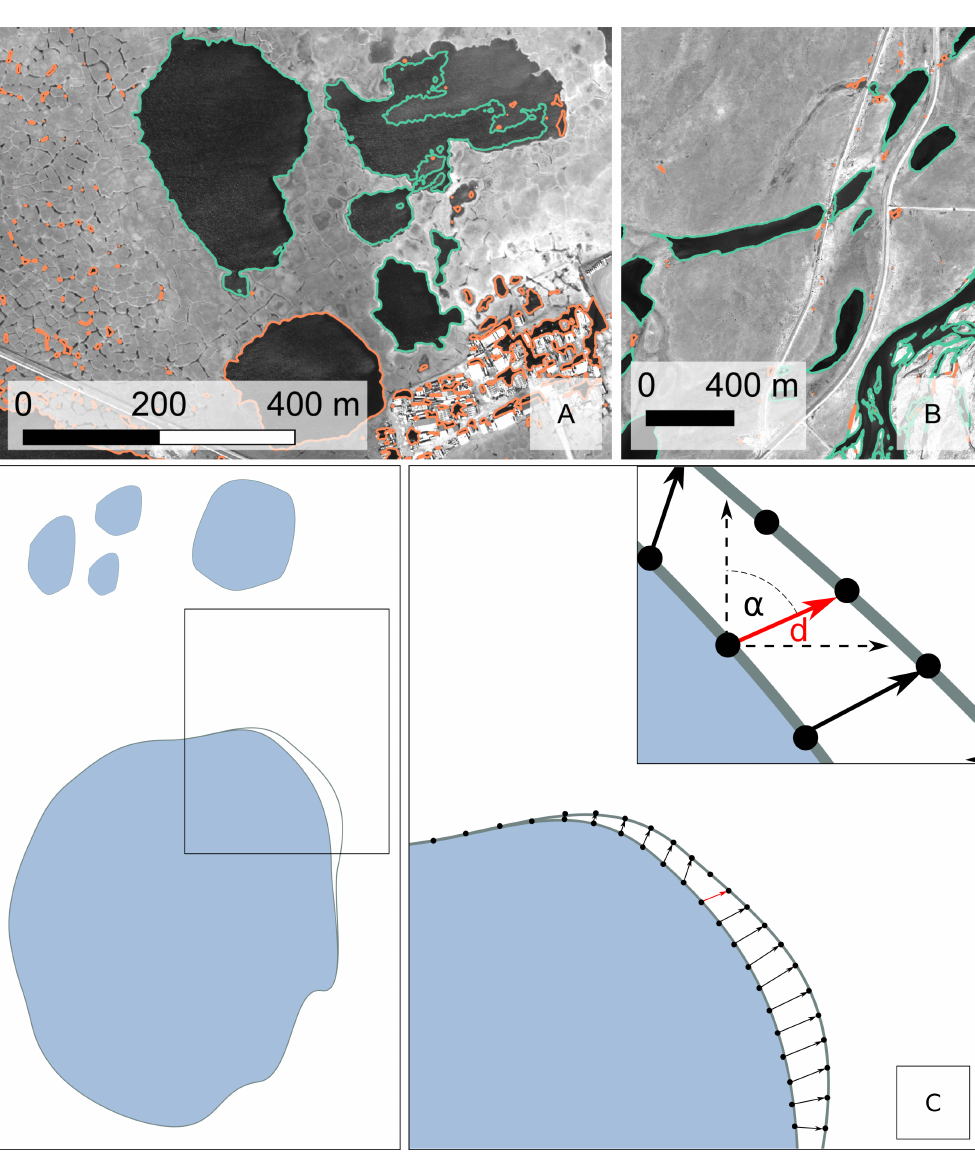
Figure 3. ( A , B ) Results of water body detection (orange lines) overlaid by water bodies after filtering of infrastructure and size (green lines). ( C ) A schematic drawing of the nearest-point analysis. For each vertex of the polygon, the nearest vertex (red arrow) of the temporally subsequent polygon is identified. The distance and direction are calculated using trigonometric